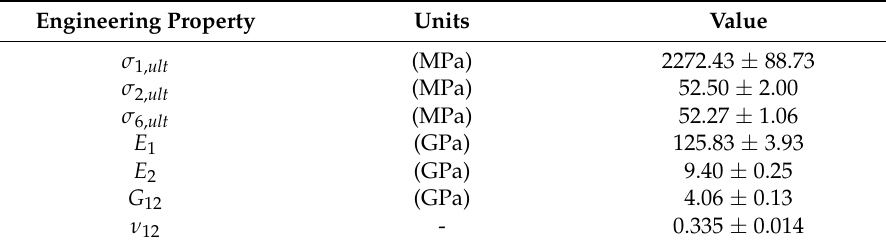
Table 1. Experimentally measured material properties. σ 1, ult —longitudinal strength; σ 2, ult —transverse strength; σ 6, ult —shear strength; E 1 —longitudinal modulus; E 2 —transverse modulus; G 12 —shear modulus; ν 12 —Poisson’s